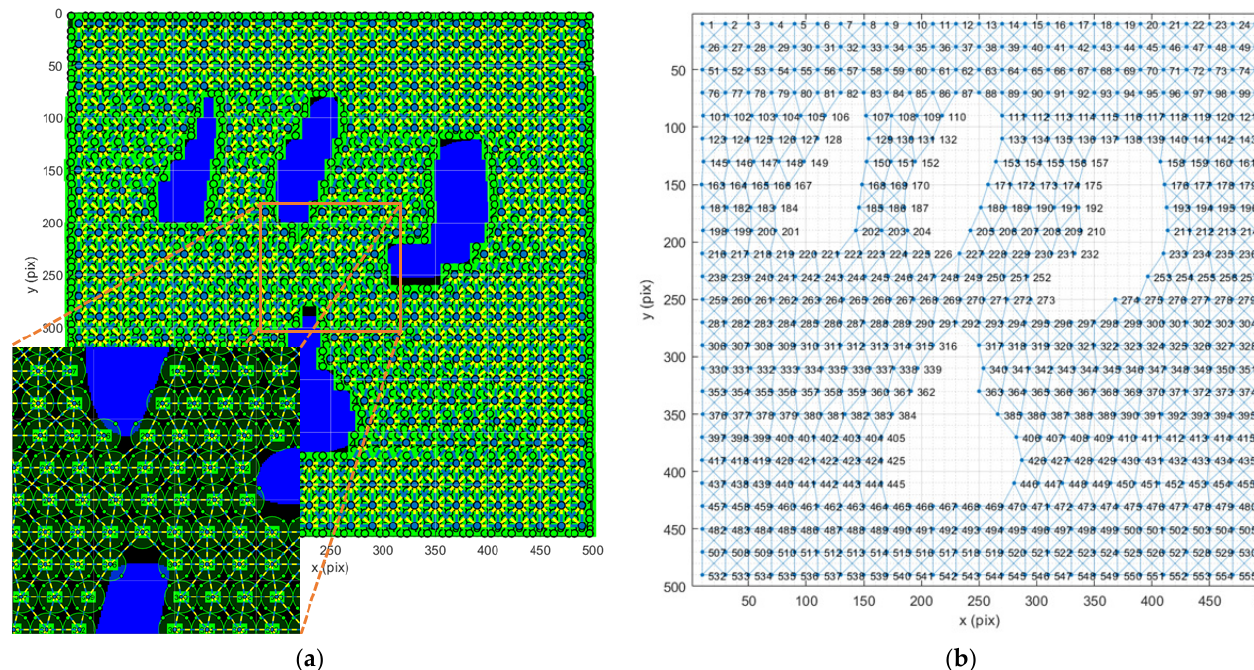
Figure 4. ( a ) Sensor fields of view placement; ( b ) corresponding terrain graph 𝐺 (cid:2869) .